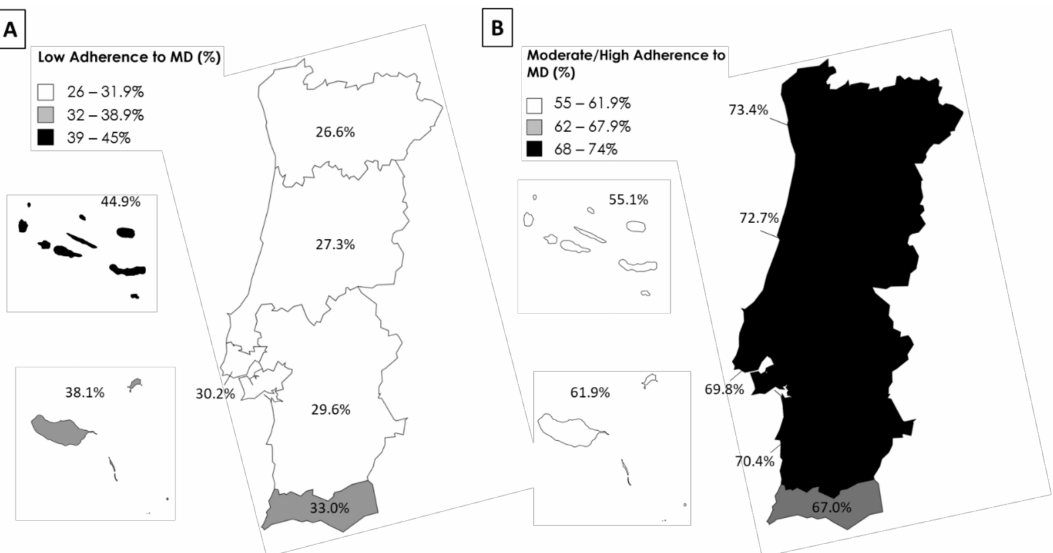
Figure 2. Low ( A ) and Moderate/High adherence ( B ) to the Mediterranean diet (MD) in Portugal according to the Nomenclature of territorial units for statistics